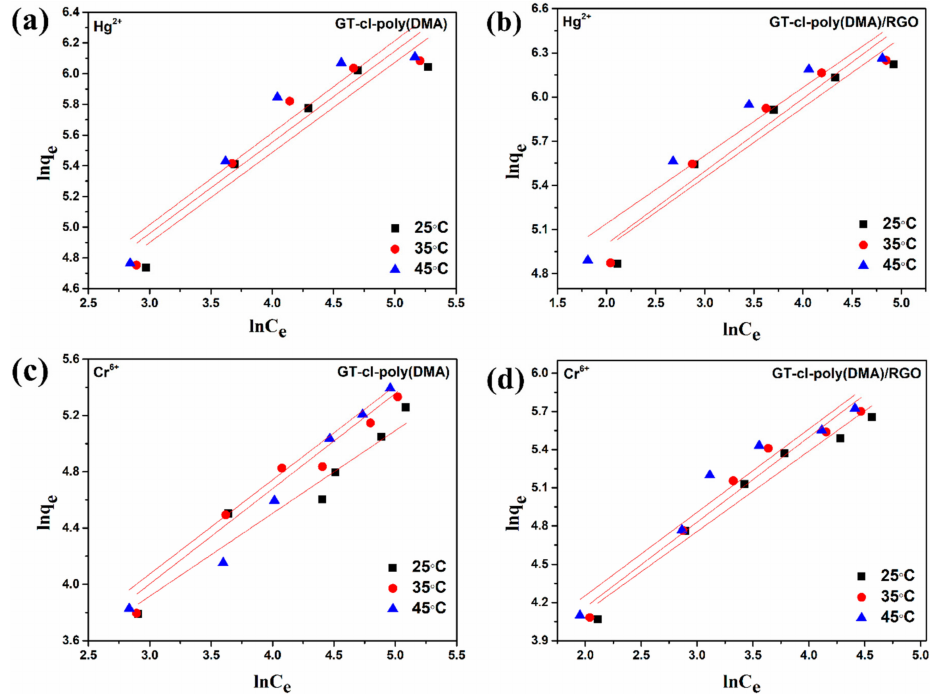
Figure 9. Freundlich isotherm model for Hg 2 + adsorption by ( a ) gum tragacanth-cl- N,N - dimethylacrylamide (GT-cl-poly(DMA)) hydrogel ( b ) reduced graphene oxide incorporated gum tragacanth-cl- N,N -dimethylacrylamide (GT-cl-poly(DMA) / RGO) hydrogel composite, Freundlich isotherm model for Cr 6 + adsorption by ( c ) gum tragacanth-cl- N,N -dimethylacrylamide (GT-cl-poly(DMA)) hydrogel ( d ) reduced graphene oxide incorporated gum tragacanth-cl- N , N - dimethylacrylamide (GT-cl-poly(DMA) / RGO) hydrogel composite, (Experimental conditions for Hg 2 + : adsorbent dose—0.035 g, pH—5.5, metal ion concentration—20 − 300 ppm, rpm = 200 and for Cr 6 + :